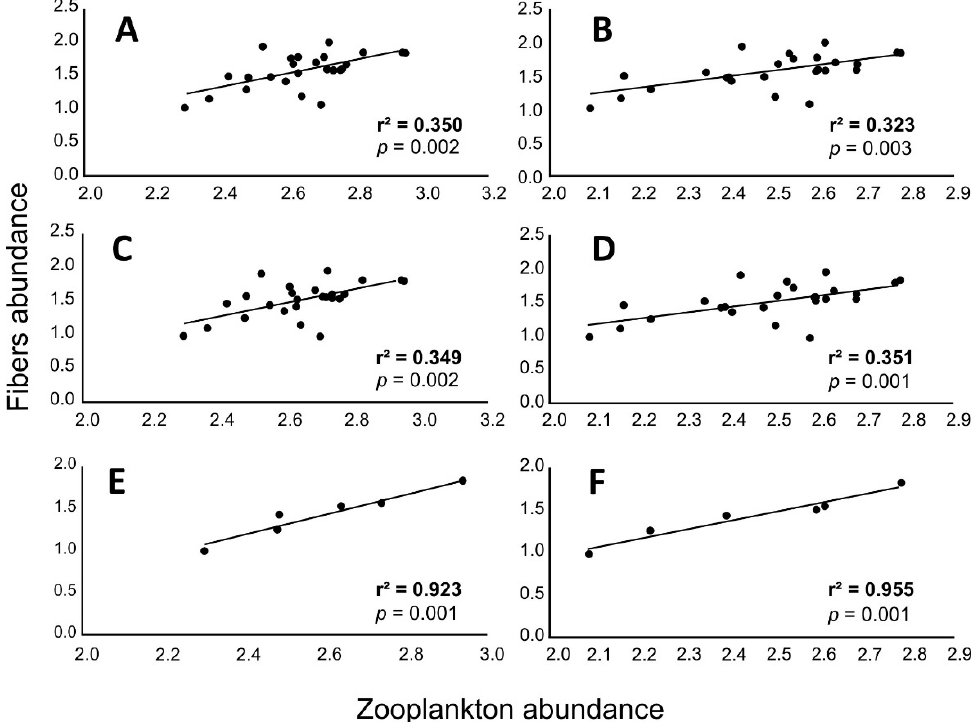
Figure 9. Pearson correlation between the abundance of the total microplastics (fibers and fragments) with ( A ) the total zooplankton and ( B ) the total copepods. Pearson correlation between the abundance of the total fibers with ( C ) the total zooplankton and ( D ) the total copepods. Pearson correlation between the abundance of the total fibers in just the area of Latsi with ( E ) the total zooplankton and ( F ) the total copepods. The values are log(X + 1) transformed. The Pearson correlation coefficient (r 2 ) and the significance level ( p ) are given on the diagrams.